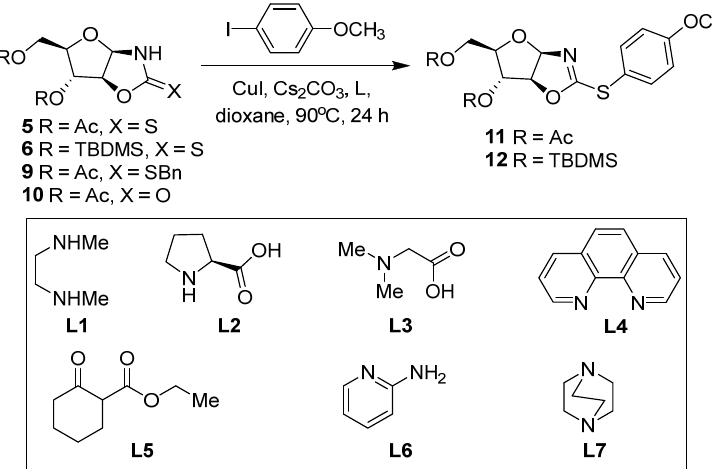
Scheme 4. Model reactions of the C-S coupling using different ratios of CuI/ligand and different Table 1. Comparative studies utilizing various ligands and ratios of catalyst and ligand [a] .